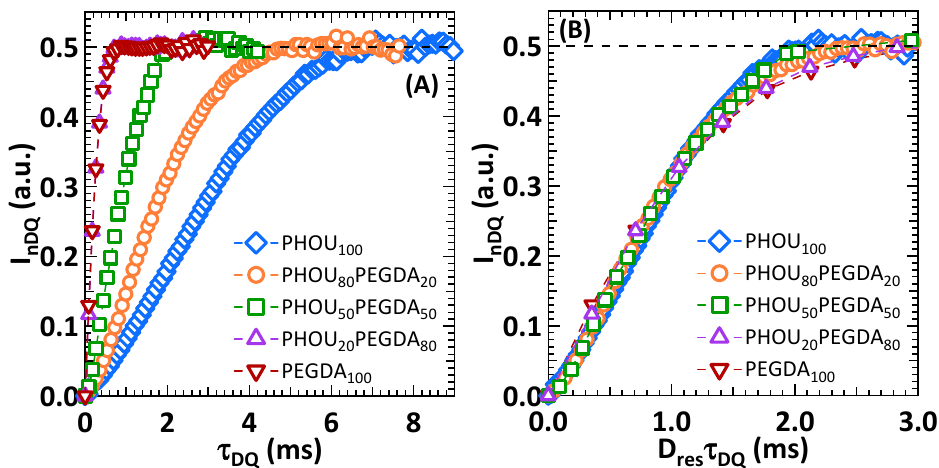
Figure 6. Normalized In DQ 1 H DQ NMR signals as a function of time τ DQ ( A ) and normalized by D res τ DQ ( B ) for all studied samples at T = T g + 90 °C. D res values are listed in Table 3. Table 3. D res and n values obtained by 1 H DQ NMR for the studied networks.